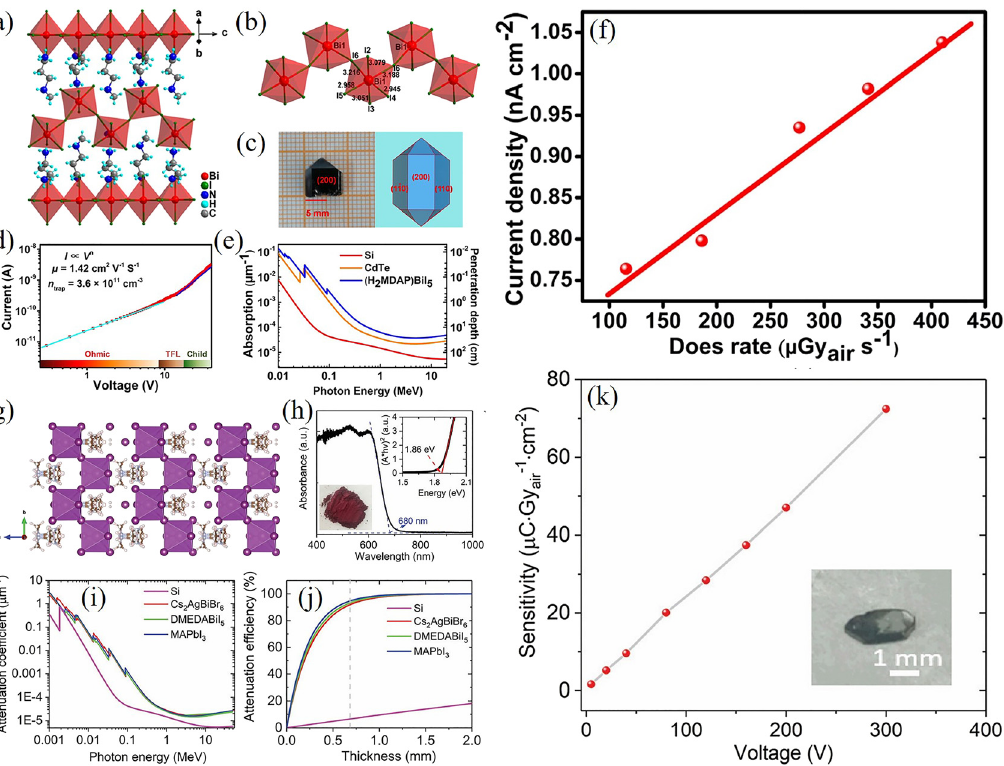
Figure 12: 1D Bi-based perovskite variants for X-ray detection. (a) Schematic view of the crystal structure of (H 2 MDAP)BiI 5 at 200 K. (b) Schematic illustration of the inorganic BiI 6 octahedra connected in a zigzag manner. (c) bulk crystal of (H 2 MDAP)BiI 5 (left) and the simulated crystal shape (right). (d) Logarithmic I – V curve of (H 2 MDAP)BiI 5 for simulating the trap state density and the charge mobility according to the SCLC method. (e) Comparison of photon energy-dependent absorption coef fi cients of (H 2 MDAP)BiI 5 , Si, and CdTe. (f) The X-ray dose rate-dependent photocurrents. Reproduced with permission. Copyright 2019, American Chemical Society [157]. (g) Schematic view of the one-dimensional (DMEDA)BiI 5 crystal structure. (h) Absorption spectrum of (DMEDA)BiI 5 in the form of powder. Left inset: The photograph of the powder. Right inset: The Tauc plot to simulate the bandgap. (i) Comparison of the simulated attenuation coef fi cients of (DMEDA)BiI 5 , Cs 2 AgBiBr 6 , MAPbI 3 , and Si versus photon energy. (j) Thickness- dependentattenuationef fi ciencyof(DMEDA)BiI 5 ,Cs 2 AgBiBr 6 ,MAPbI 3 ,andSitowardsX-rayof50keVphotonenergy.Thedottedlinedenotesa thickness of 690 mm. (k) Photocurrent as a function of X-ray dose rate. Inset: the photograph of the (DMEDA)BiI 5 single crystal. Reproduced with permission. Copyright 2020, the Royal Society of Chemistry